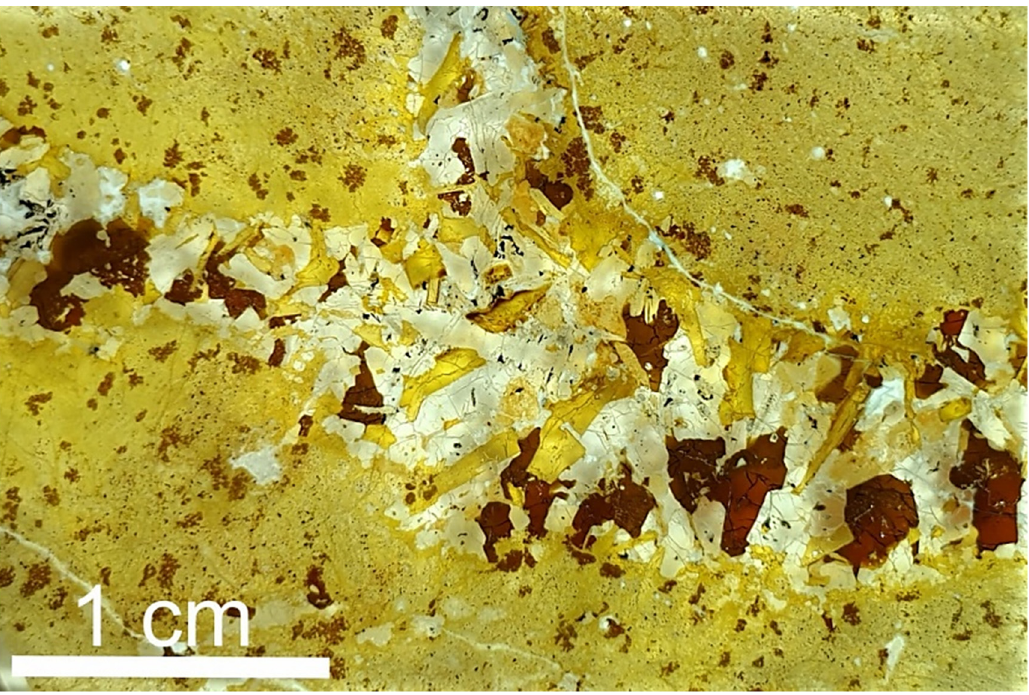
Figure 2. Rankinite paralava in gehlenite hornfels, Gurim anticline (in plane polarized light). Brown: Ti-bearing andradite; yellow of different hues: gehlenite; colorless: rankinite, wollastonite cuspidine and fluorapatite; black: magnesiochromite.